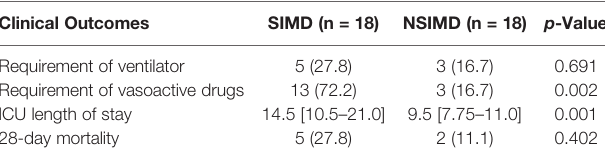
TABLE 2 | Comparison of clinical outcomes between the SIMD and NSIMD groups. Clinical Outcomes